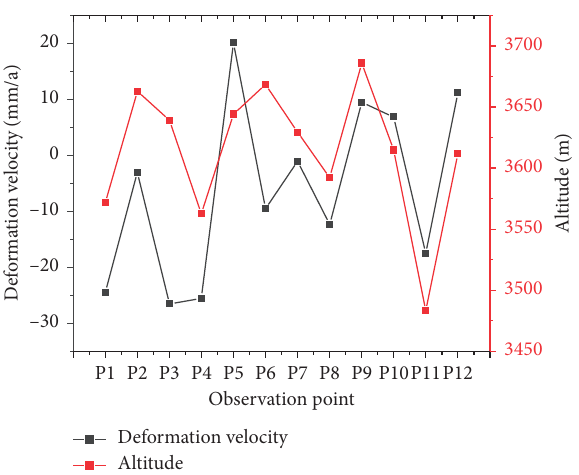
Figure 7: Relationship between the deformation velocity and al- titude of the observation